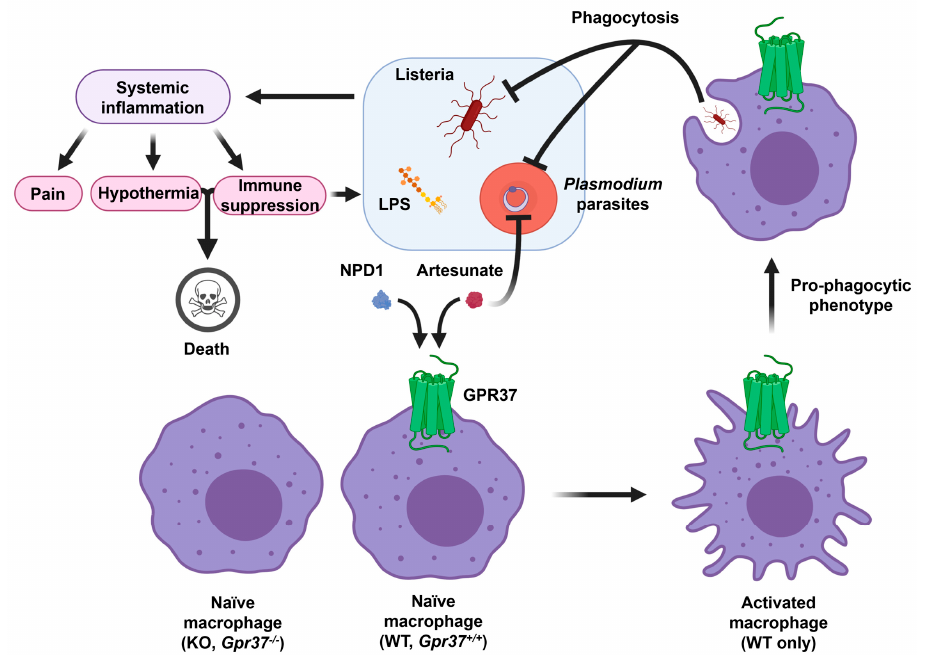
Figure 5. Schematic of GPR37 activation in macrophages for protection against infections. Infections by lipopolysaccharide (LPS), listeria, and parasites cause systemic inflammation, which is associated with severe pain, hypothermia, cytokine storm/immune suppression, and septic death. GPR37 activation in wild-type (WT) macrophages by NPD1 and artesunate can promote macrophage phago- cytosis, leading to clearance of listeria bacteria and plasmodium-infected red blood cells. In contrast, GPR37-deficient macrophages will exacerbate inflammation, pain, and septic death. This figure is reproduced from Bang et al., Nat Commun, 2021 with permission [36]. This is an open access